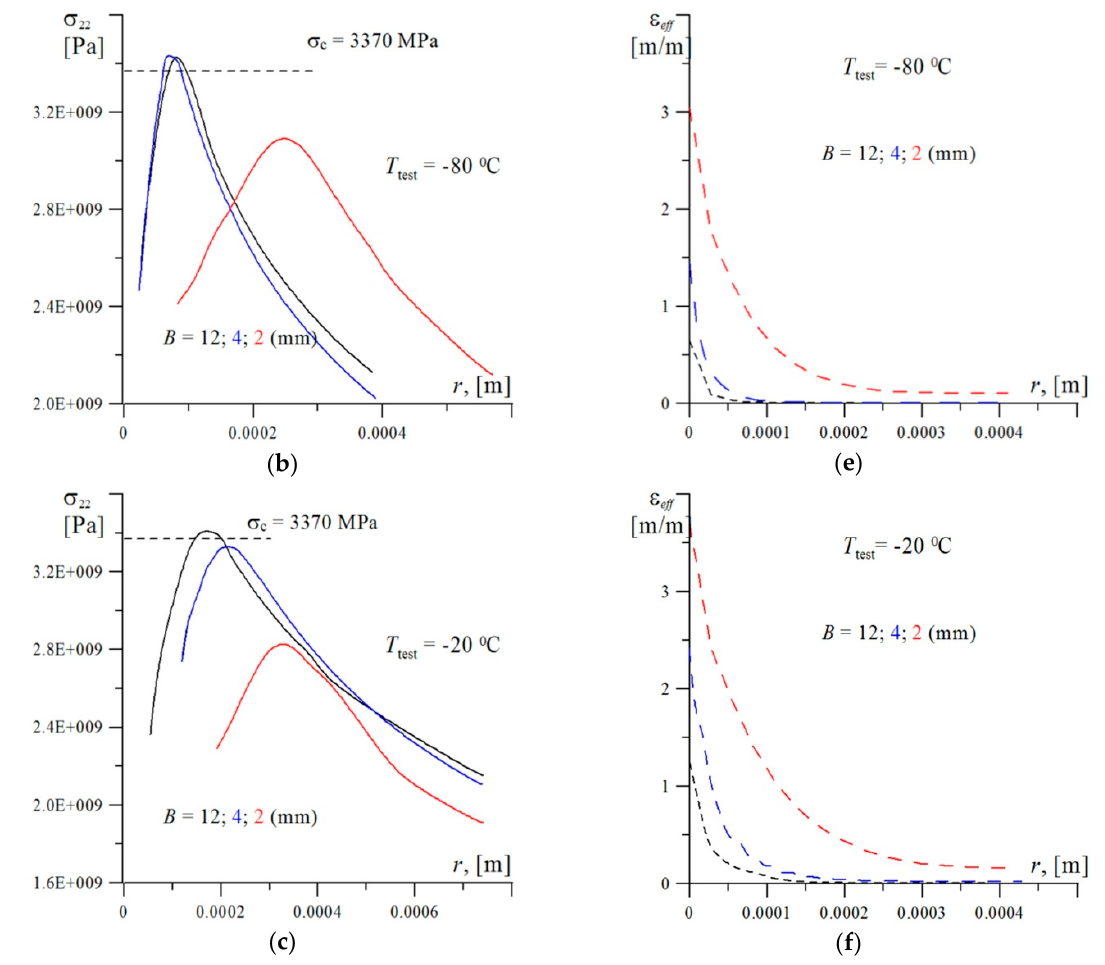
Figure 10. ( a ) The distributions of σ 22 for specimens of B = 12. 0, 4.0, 2.0 (mm) at T test = − 100 °C ; ( b ) − 80 °C; ( c ) − 20 °C. ( d ) The distributions of σ * 22 through thickness for specimens of B = 12. 0 and 2.0 (mm) at T test = − 100 °C and − 80 °C. ( e ) The distributions of ε eff for specimens of B = 12. 0, 4.0, 2.0 (mm) at T test = − 80 °C and ( f ) − 20 °C.